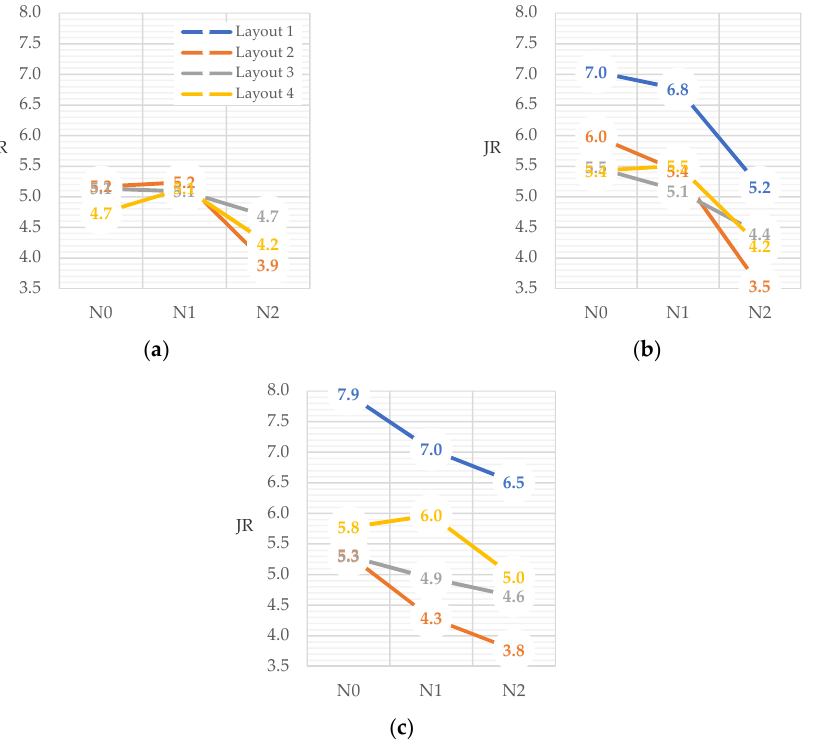
Figure 12. Performance indicator J R : ( a ) damage scenario D1; ( b ) damage scenario D2; ( c ) damage scenario D3.